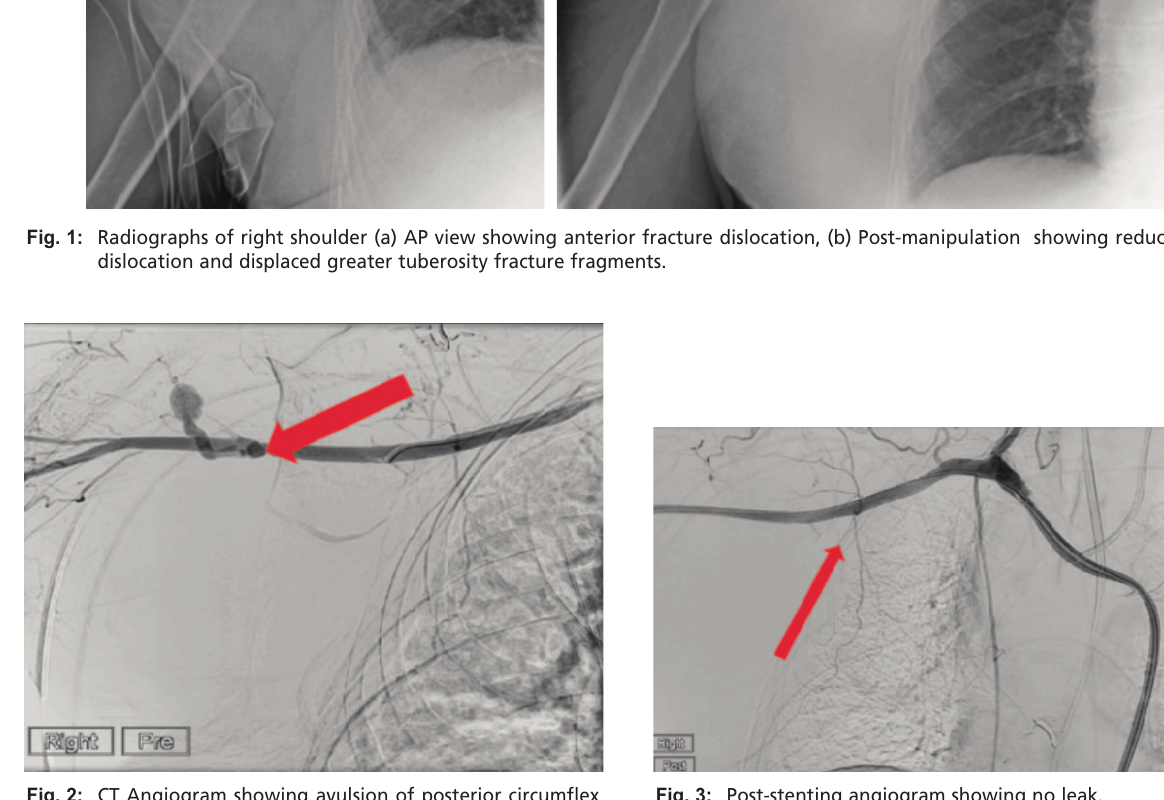
CT Angiogram showing avulsion of posterior circumflex Fig. 2: branch from axillary artery.